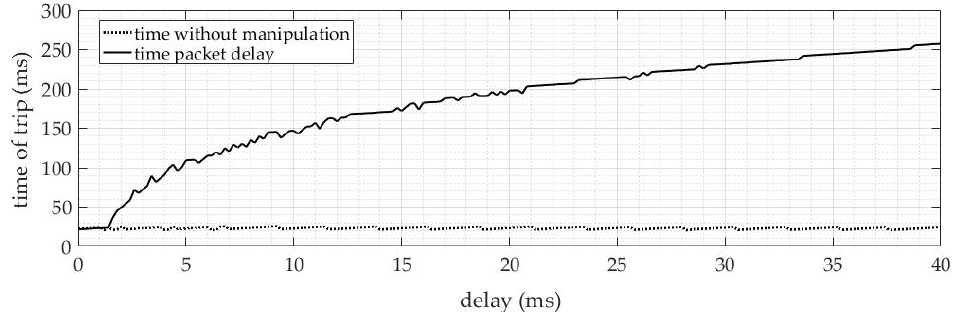
Figure 15. Tripping time results ANSI 50 — delayed packets.